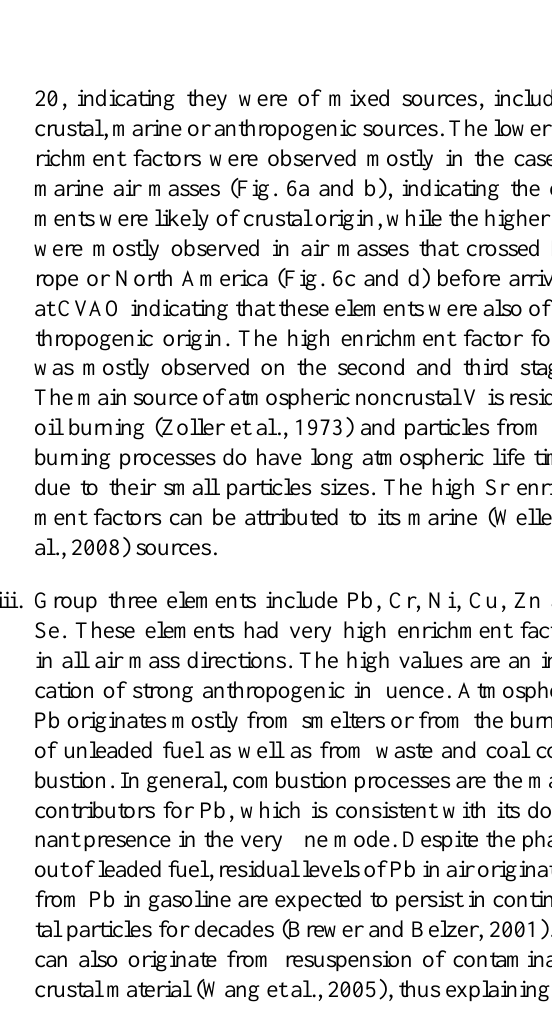
Fig. 6. Enrichment factors of the measured elements in each impactor stage and each air mass origin from (a) AM, (b) MC, and (c) ME to (d)